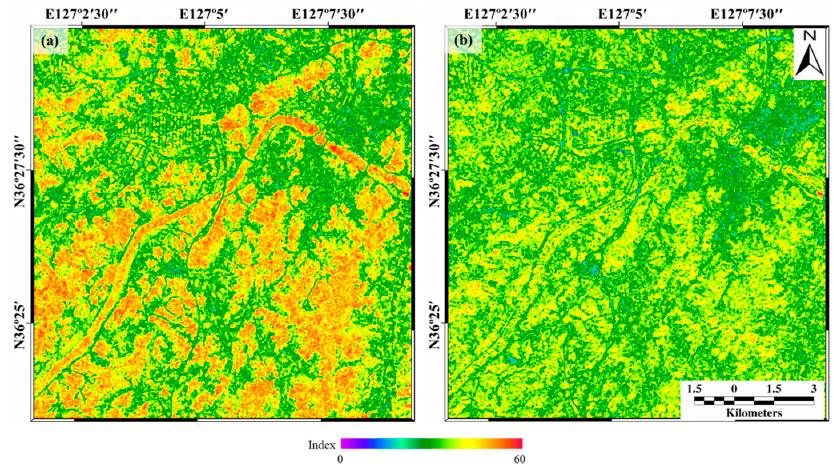
Figure 9. Input neurons of PCA texture created from Sentinel-2 image: ( a ) spring and ( b ) fall season.